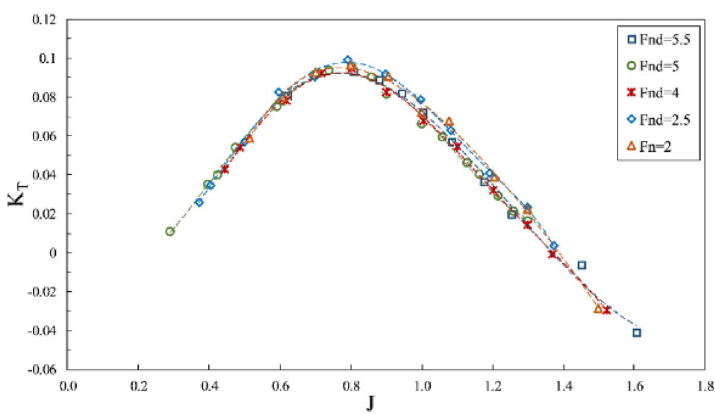
Figure 10. Thrust coefficient in propeller direction in different Froude numbers ( I = 0.4, α = 3 ◦